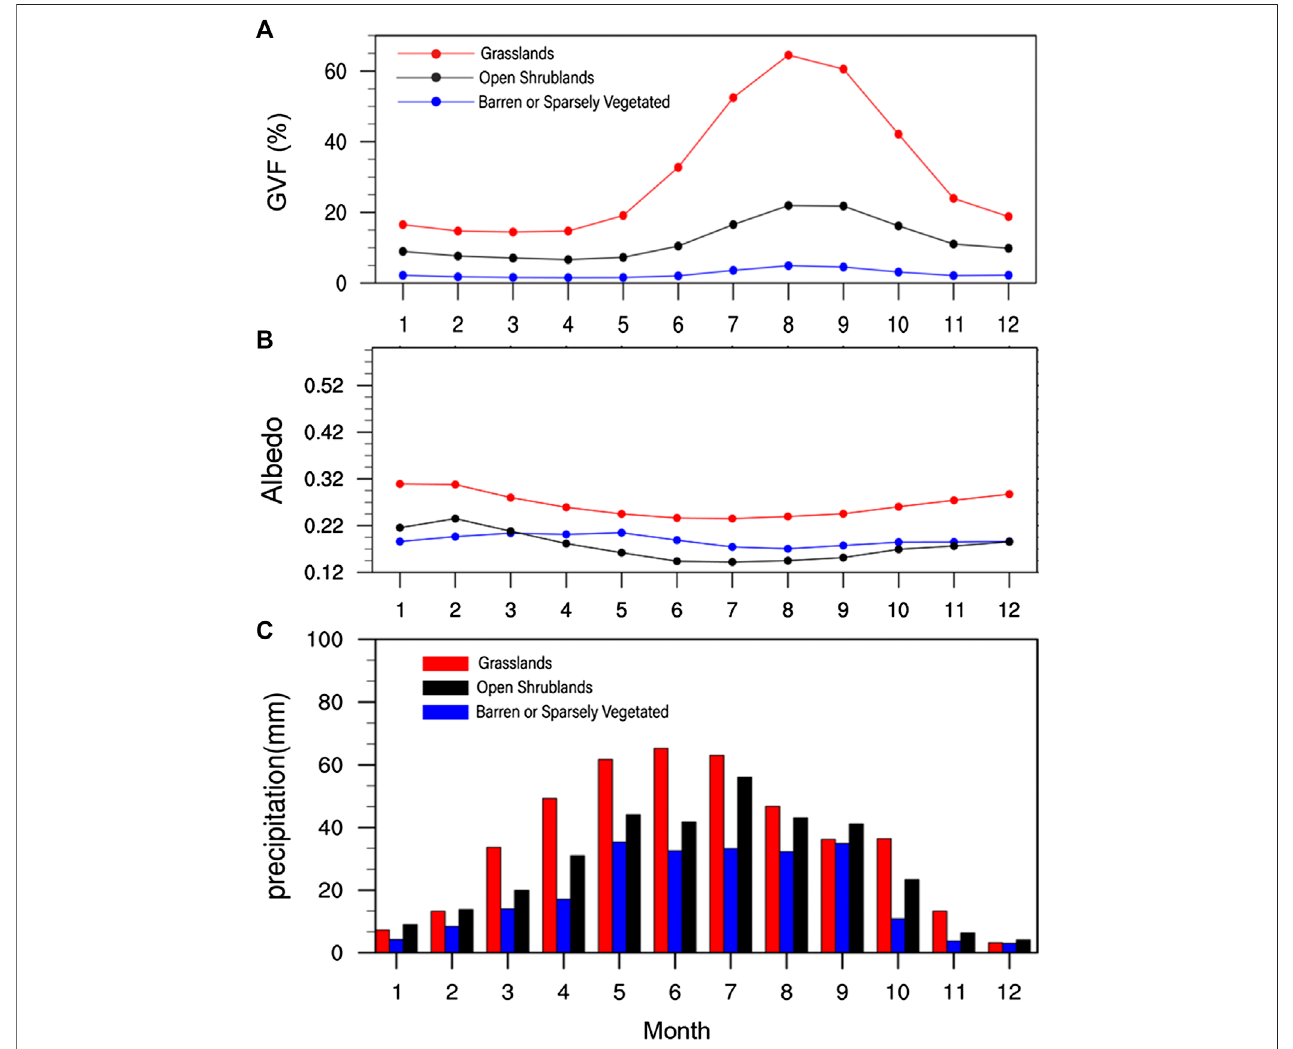
FIGURE 5 | The monthly averaged variation of (A) Green Vegetation Fraction (Unit: %), (B) Albedo and (C) precipitation (Unit: mm) over Grassland, Open shrublands, and Barren or sparsely vegetated in Qinghai-Tibet Plateau.